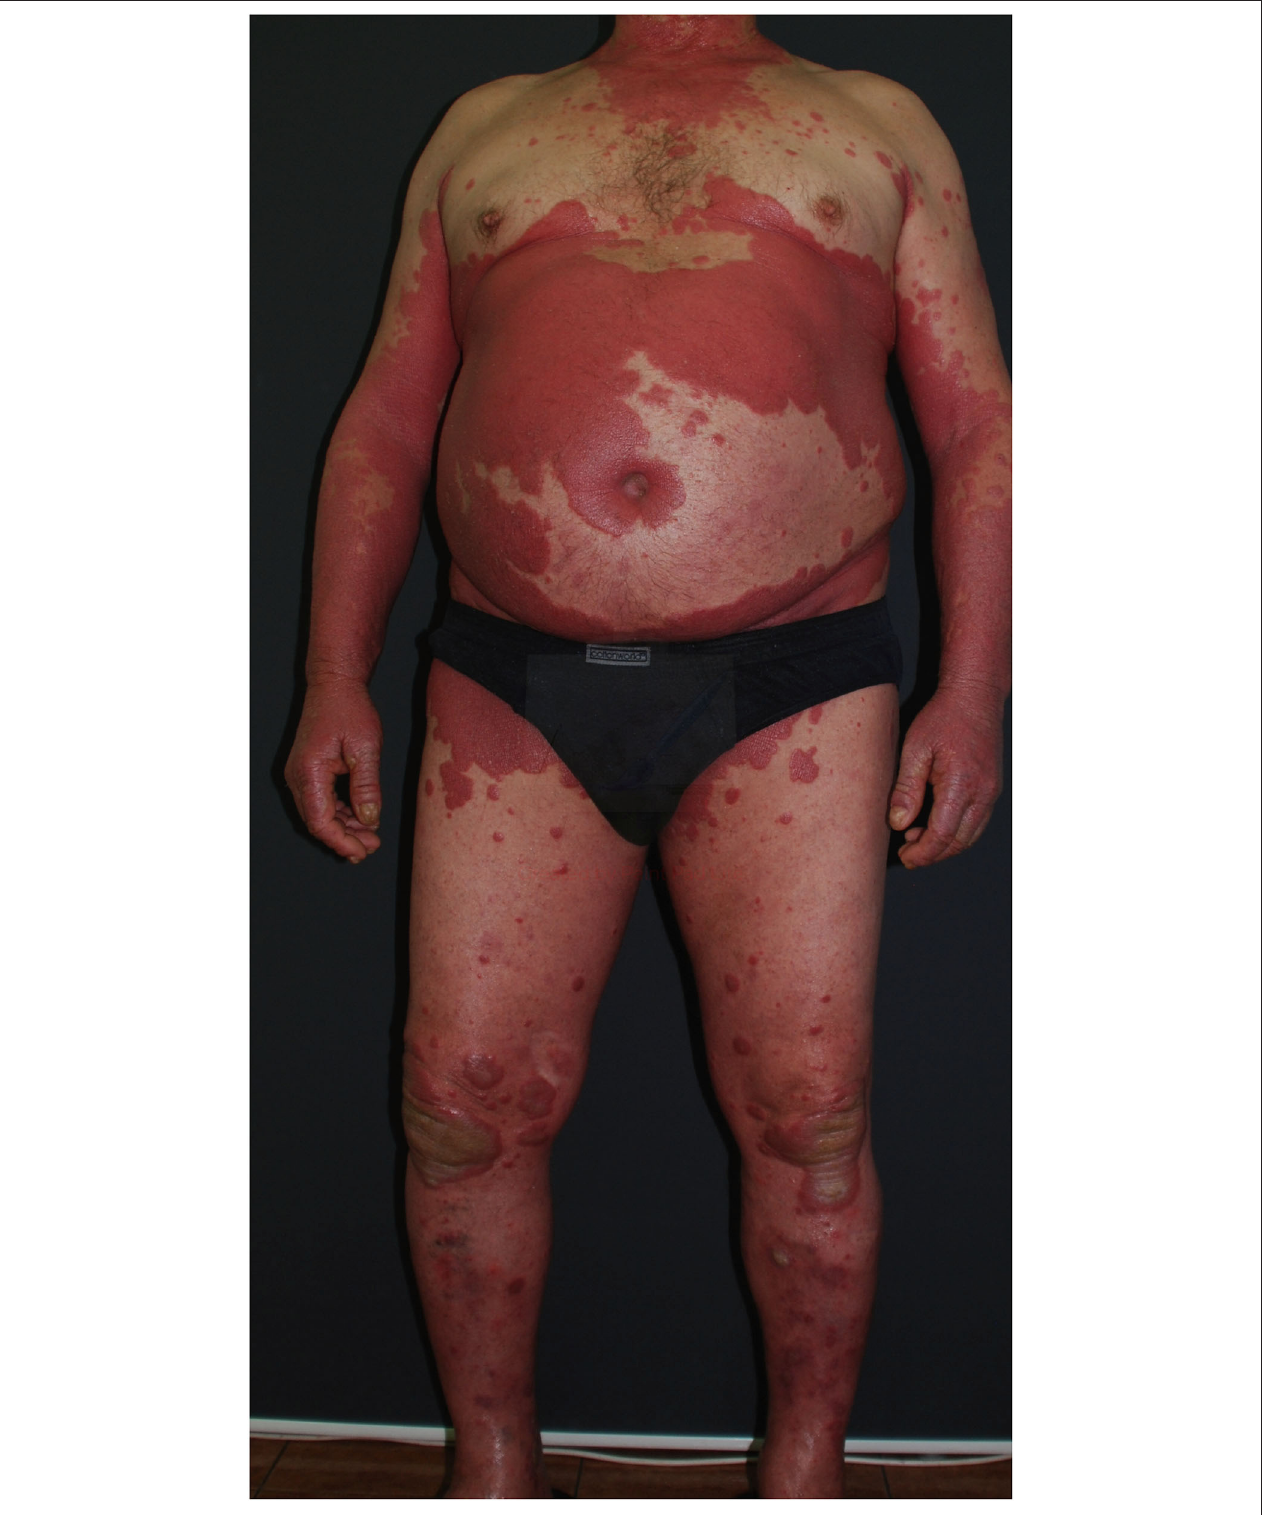
FIGURE 3 | Erythematous and scaly psoriatic lesions affecting large area of the body (from the archives of Dermatology Department).